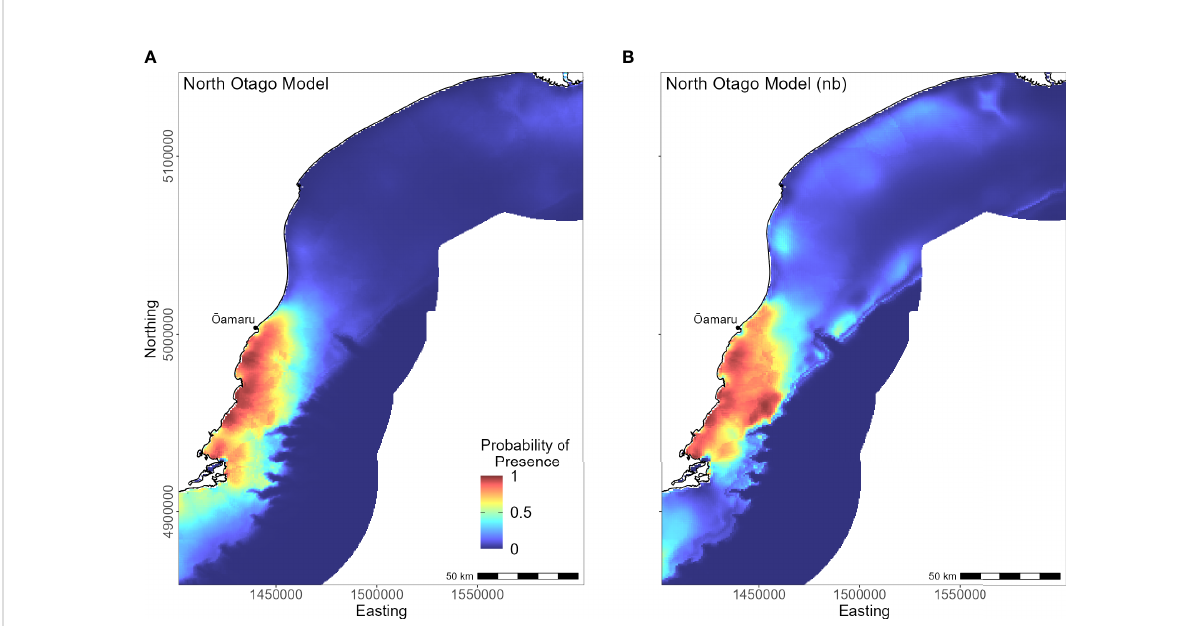
FIGURE 7 Distribution of suitable habitat for yellow-eyed penguins breeding on North Otago. The left map (A) depicts the predicted probability of presence (cloglog) with distance to nearest colony included a predictor variable, while the right map (B) does not include distance to colony as a predictor (nb model).